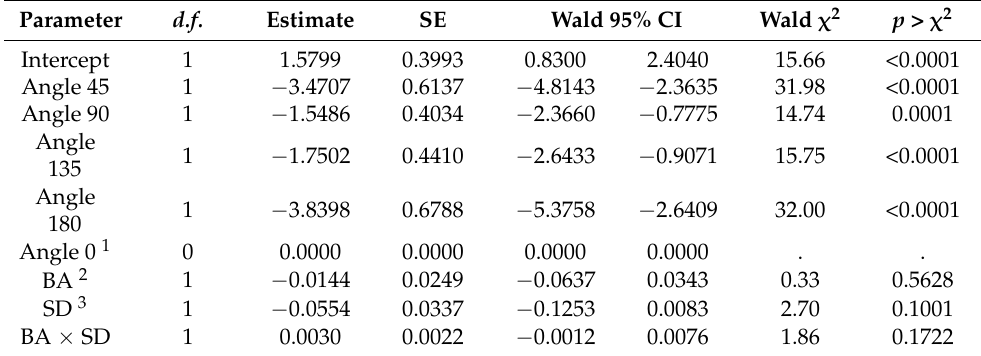
Table 6. Parameter estimates for generalized linear model results of synthetic bat echolocation playback response within an anechoic chamber to detector angle ( ◦ ) and simulated clutter variation represented by basal area (m 2 /ha) and stem density (stem count) for the probability of correctly classifying the synthetic eastern red bat ( Lasiurus borealis ) call, Blacksburg, VA, USA, 2016. Detectors recorded in full spectrum (see text for details). d.f.